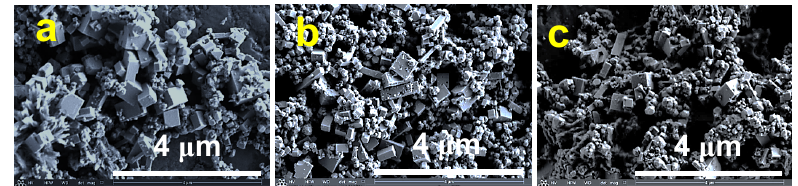
Figure 7. SEM images of the as-synthesized pyrite crystals at 24 h with Na 2 S and S powder as the sulfur source: ( a ) 5 mmol / L Na 2 S + 5 mmol / L S powder, ( b ) 10 mmol / L Na 2 S + 10 mmol / L S powder, and ( c ) 15 mmol / L Na 2 S + 15 mmol / L S